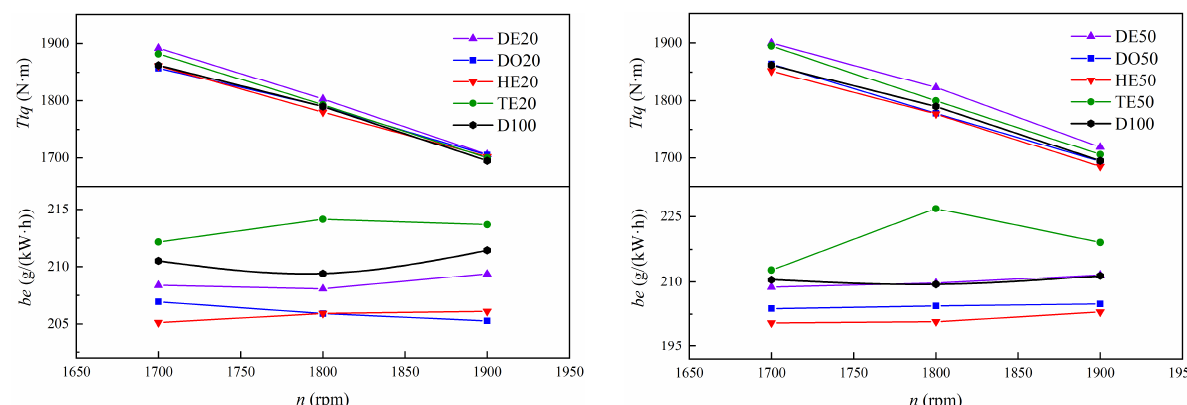
Figure 5. The power and economy performance at 100% load.